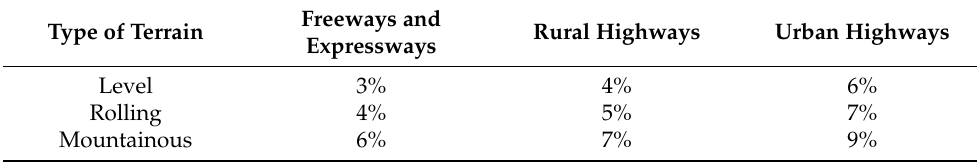
Table 1. Maximum grades for types of highway and terrain conditions.